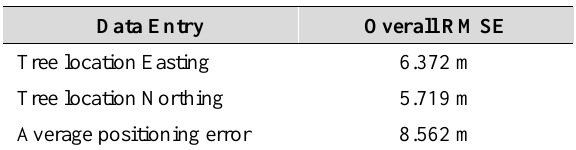
Table 2. Overall RMSE of data entry in task 2